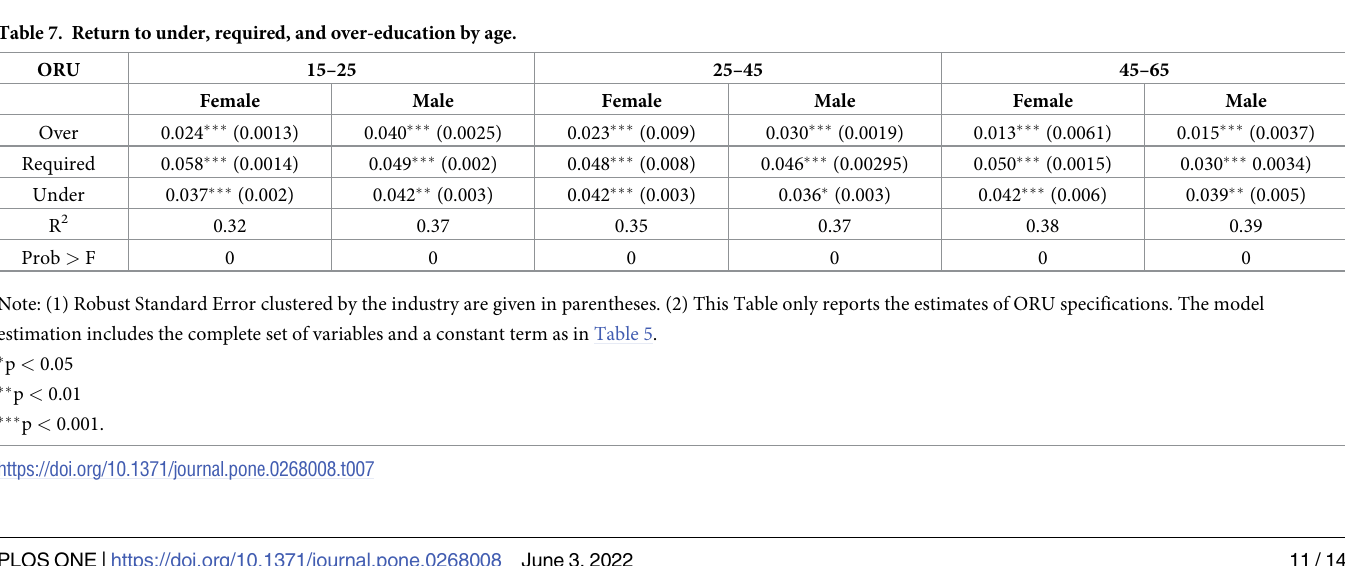
Table 7. Return to under, required, and over-education by age.